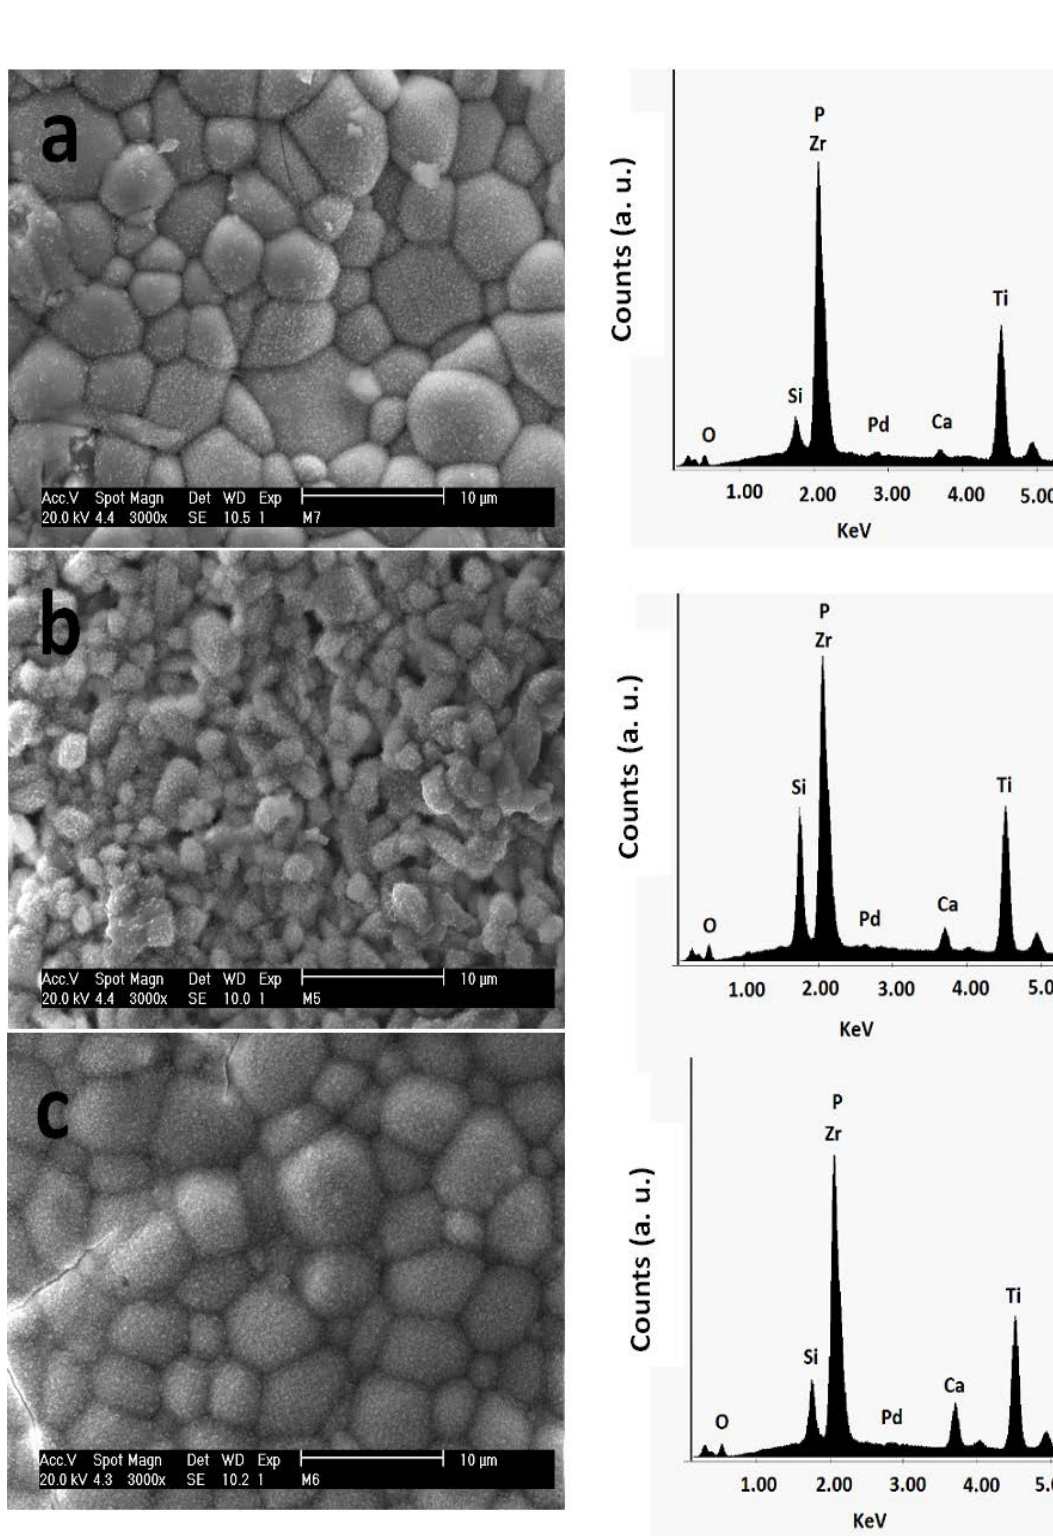
after 7 days (a), 14 days (b) and 21 days (c), of immersion in SBF 4